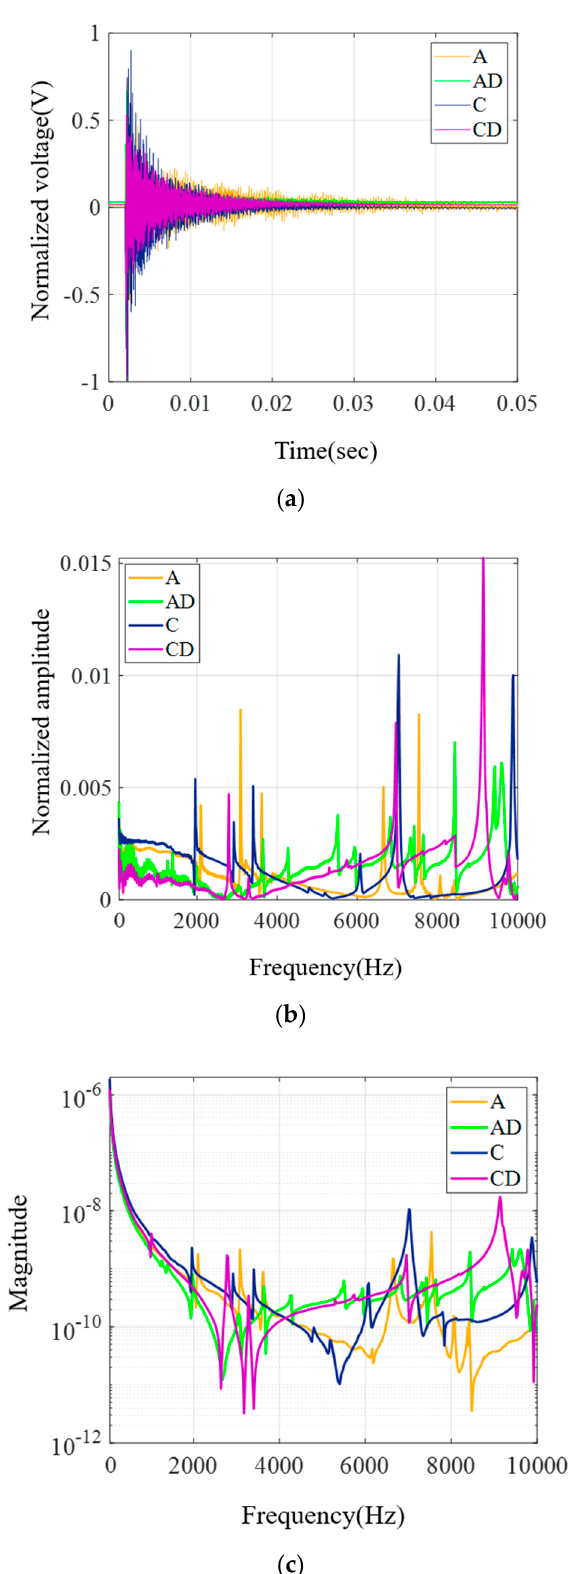
Figure 5. Comparison of time, FFT, and FRF results by the impact of the cap: ( a ) time domain of normal and damaged cap specimens; ( b ) FFT domain of normal and damaged cap specimens; and ( c ) FRF domain of normal and damaged cap specimens.